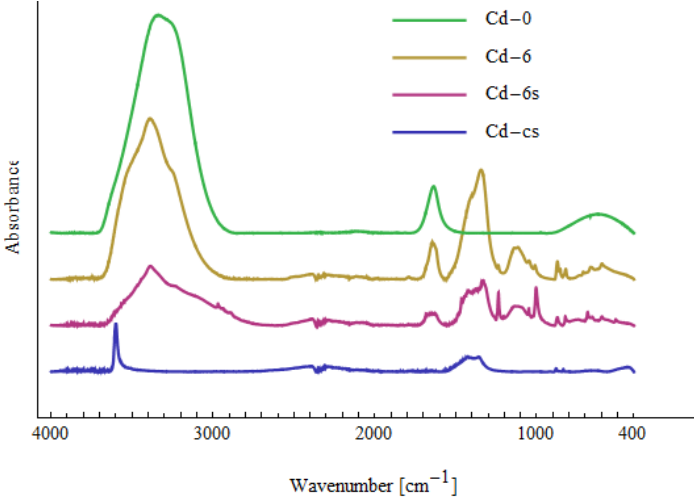
Figure 7. FTIR spectra related to solutions containing Cd(II).